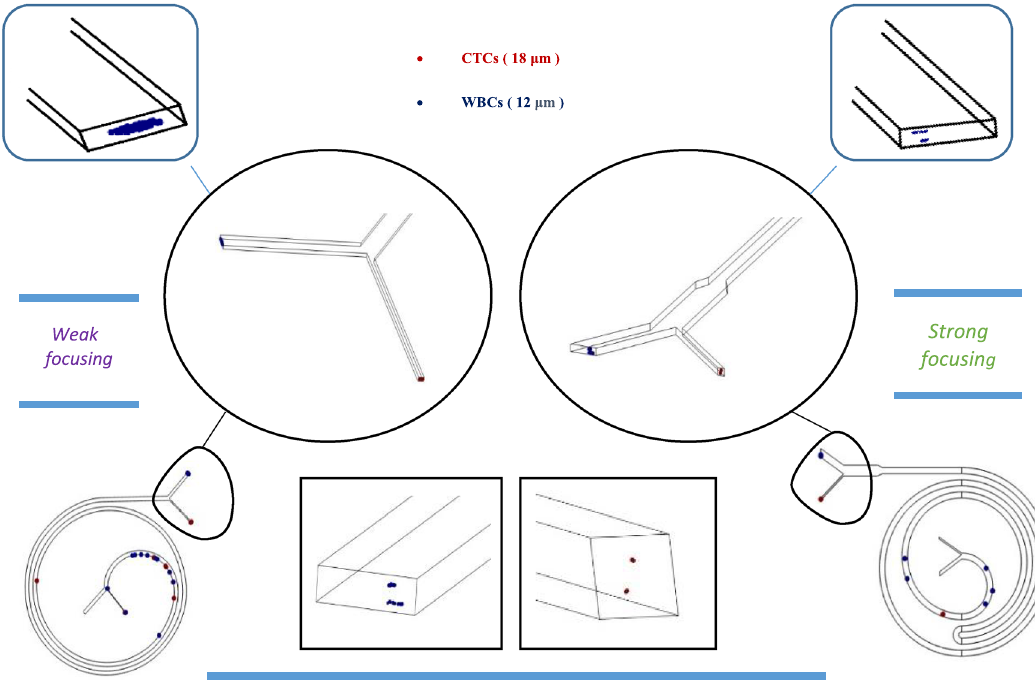
Figure 5. The COMSOL software simulation results, at first, particles were traced in a conventional microchannel at 0.9 mL/min, then a U turn was added to the way of particles and showed that due to the higher curvature ratio, smaller particles completely migrate toward the outer wall at 1.7 mL/min. The equilibrium position of the cells, which exist in two separate pieces at the outlet, indicates the presence of two transverse vertices. Red particles are 18 µm and blue particles are 12 µm in diameter. These particles mimick the behavior of WBCs and CTCs respectively (COMSOL Multiphysics ® Version 6.0 is available: https:// www. comsol. com/ relea se/6.0).